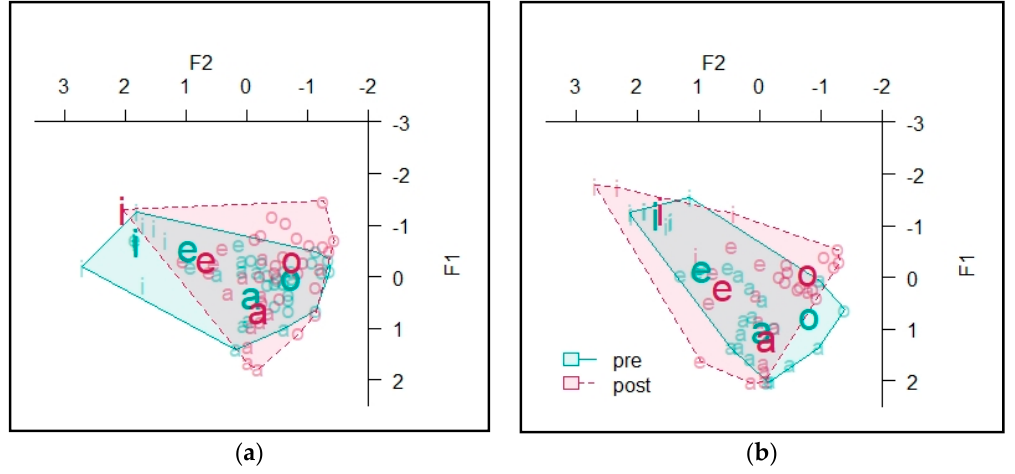
Figure 10. Informant D vowel spaces from pre-semester and post-semester measurements: ( a ) vowels from unstressed syllables; ( b ) vowels from stressed syllables.